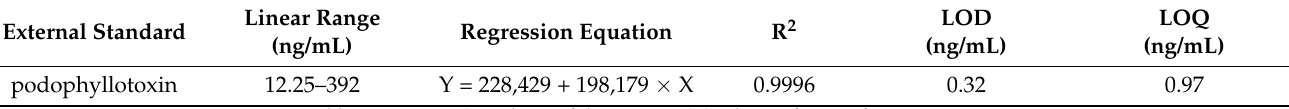
Table 6. Linearity parameters of the PPT calibration curve and limits of detection and quantification.